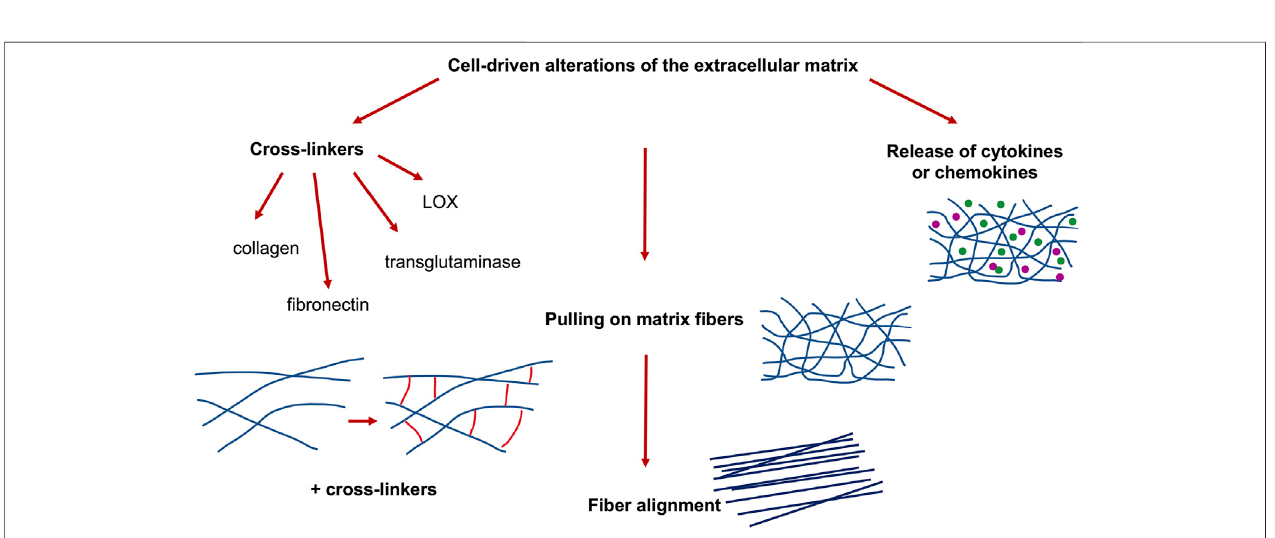
FIGURE 5 | Cell-driven alterations of 3D extracellular matrix scaffolds, such as cross-linking of cell-derived molecules, cellular pulling on collagen fi bers and cell- released cytokines or chemokines.